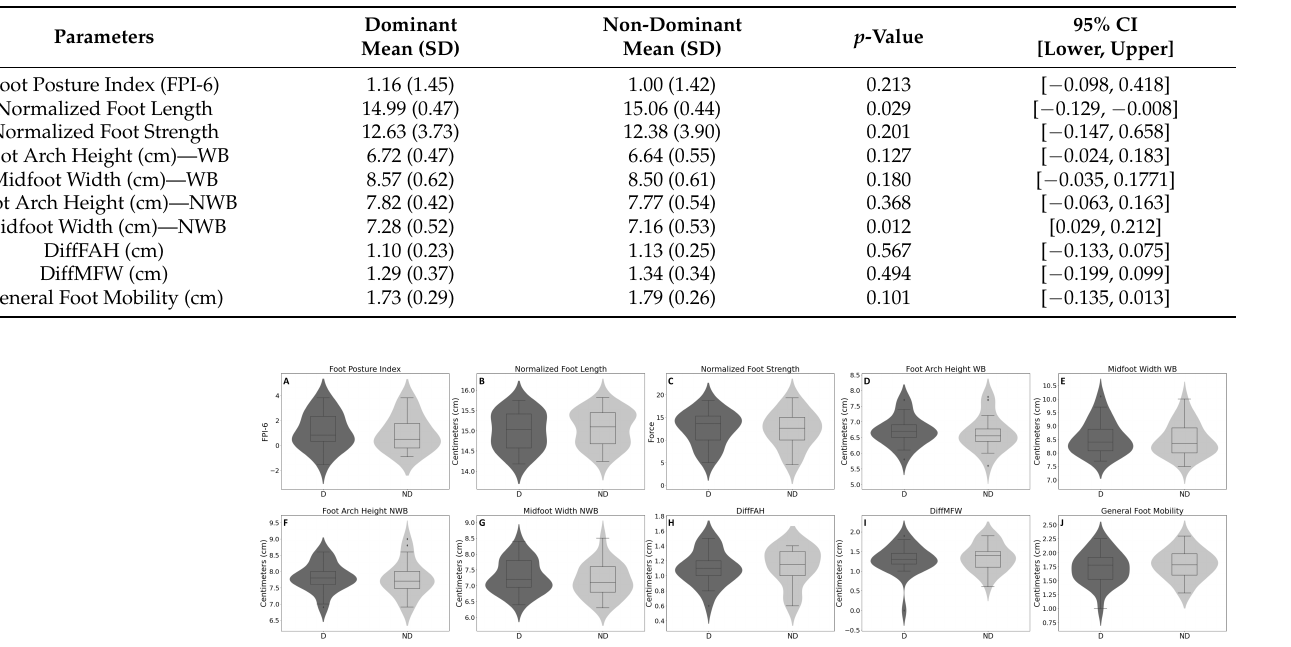
Table 2. Characteristics of the foot posture and mobility for the dominant and non-dominant sides.